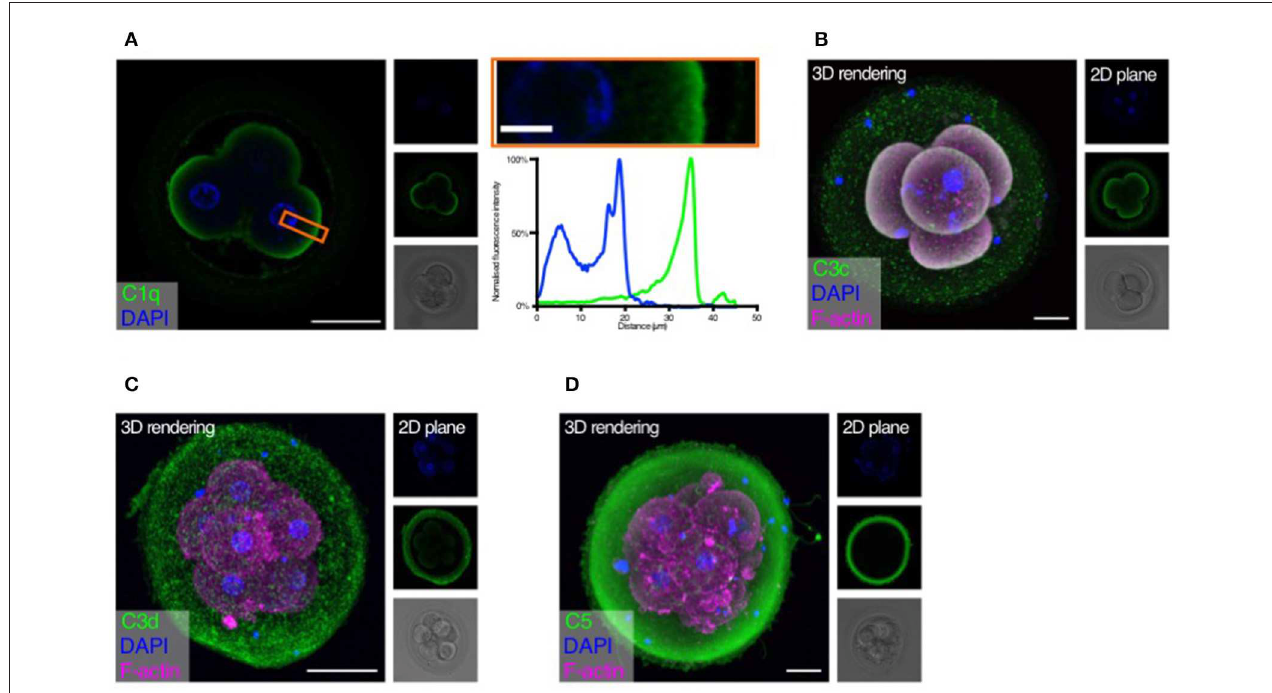
FIGURE 2 | Complement targets developing embryos. Human cleavage stage in vitro fertilization (IVF) embryos were thawed in Vitrolife G-TL serum-free media. The embryos were then incubated with specific anti-complement antibodies and analyzed by confocal microscopy. Analysis of embryonic binding of complement activation products revealed binding of the classical pathway initiator C1q (A) , and deposition of cascade activation components C3c/C3b/iC3b (B) , and C3d (C) . Finally, activation of the terminal pathway is evidenced by deposition of C5 (D) . (A) Left panel: Single plane, overlay of C1q (green) and DAPI (blue). Middle panels top to bottom: DAPI, C1q, and BF. Right panels: Magnification of overlay (orange insert), and below the cross-sectional distribution of fluorescence intensity. This shows C1q is specifically found on the cell surface. (B–D) Left panels: 3D rendering, overlay of protein stain (green), DAPI (blue), and F-actin (magenta). Right panels top to bottom: DAPI, protein stain, and brightfield (BF). Scale bars: 50 µ m, insert: 10 µ m. For each staining, n = 3 to 4 + 1 to 3 (2PN + 3PN